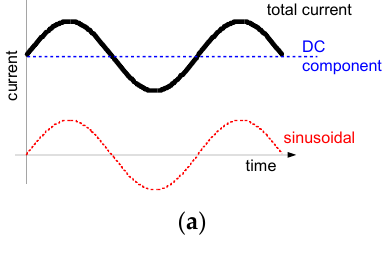
Figure 2. Composite waveforms of earth fault currents (“total current”) in the coupled DC–AC systems. Components: ( a ) sinusoidal AC + smooth DC; ( b ) pulsating half-wave + smooth DC of same polarity; ( c ) pulsating half-wave + smooth DC of opposite polarity.